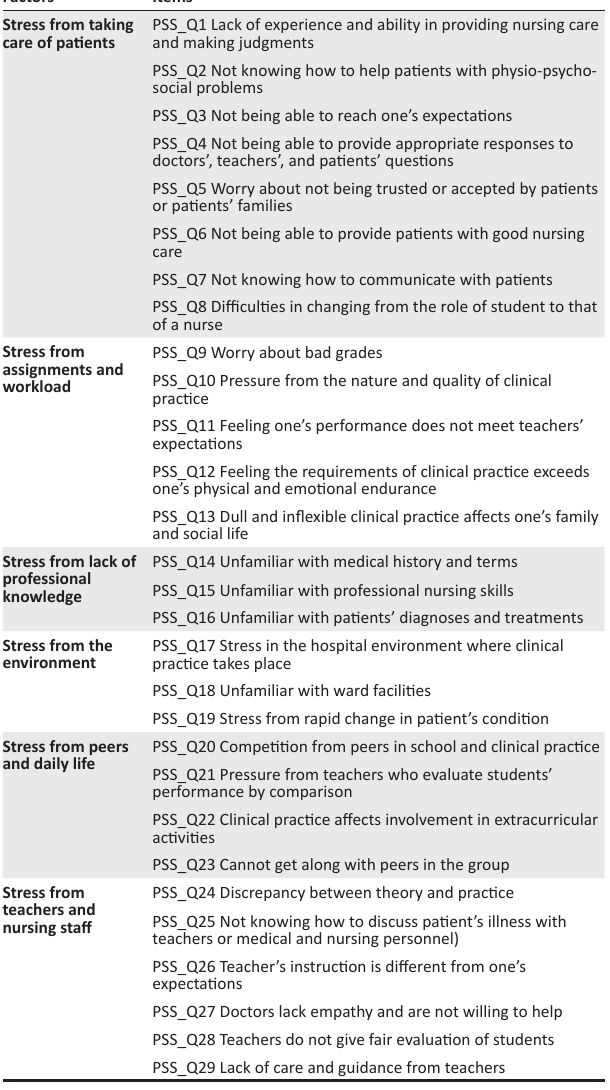
TABLE 1: Factor structure of the perceived stress scale